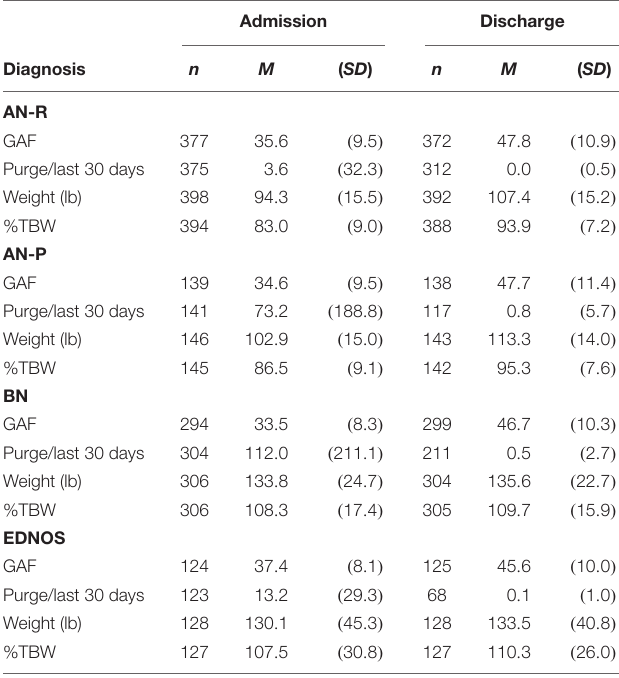
Note. Of the 979 adolescent patients, the 399 patients diagnosed with AN-R had a mean age of 14.6 (SD = 1.7) and mean length of stay (LOS) of 55.9 (SD = 30.6), the 146 patients diagnosed with AN-P had a mean age of 15.4 (SD = 1.5) and mean LOS of 50.1 (SD = 25.9), the 306 patients diagnosed with BN had a mean age of 15.8 (SD = 1.2) and mean LOS of 40.6 (SD = 25.1), and the 128 patients diagnosed with EDNOS had a mean age of 15.1 (SD = 1.6) and mean LOS of 36.7 (SD =